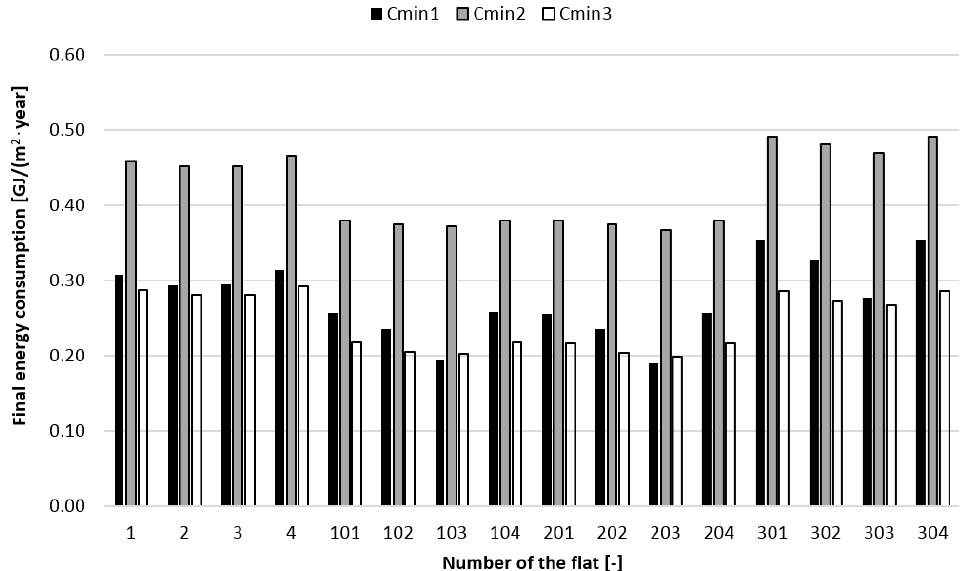
Figure 4. Unit minimum final energy consumption in the individual apartments of the studied building after thermorenovation for the analyzed methods.